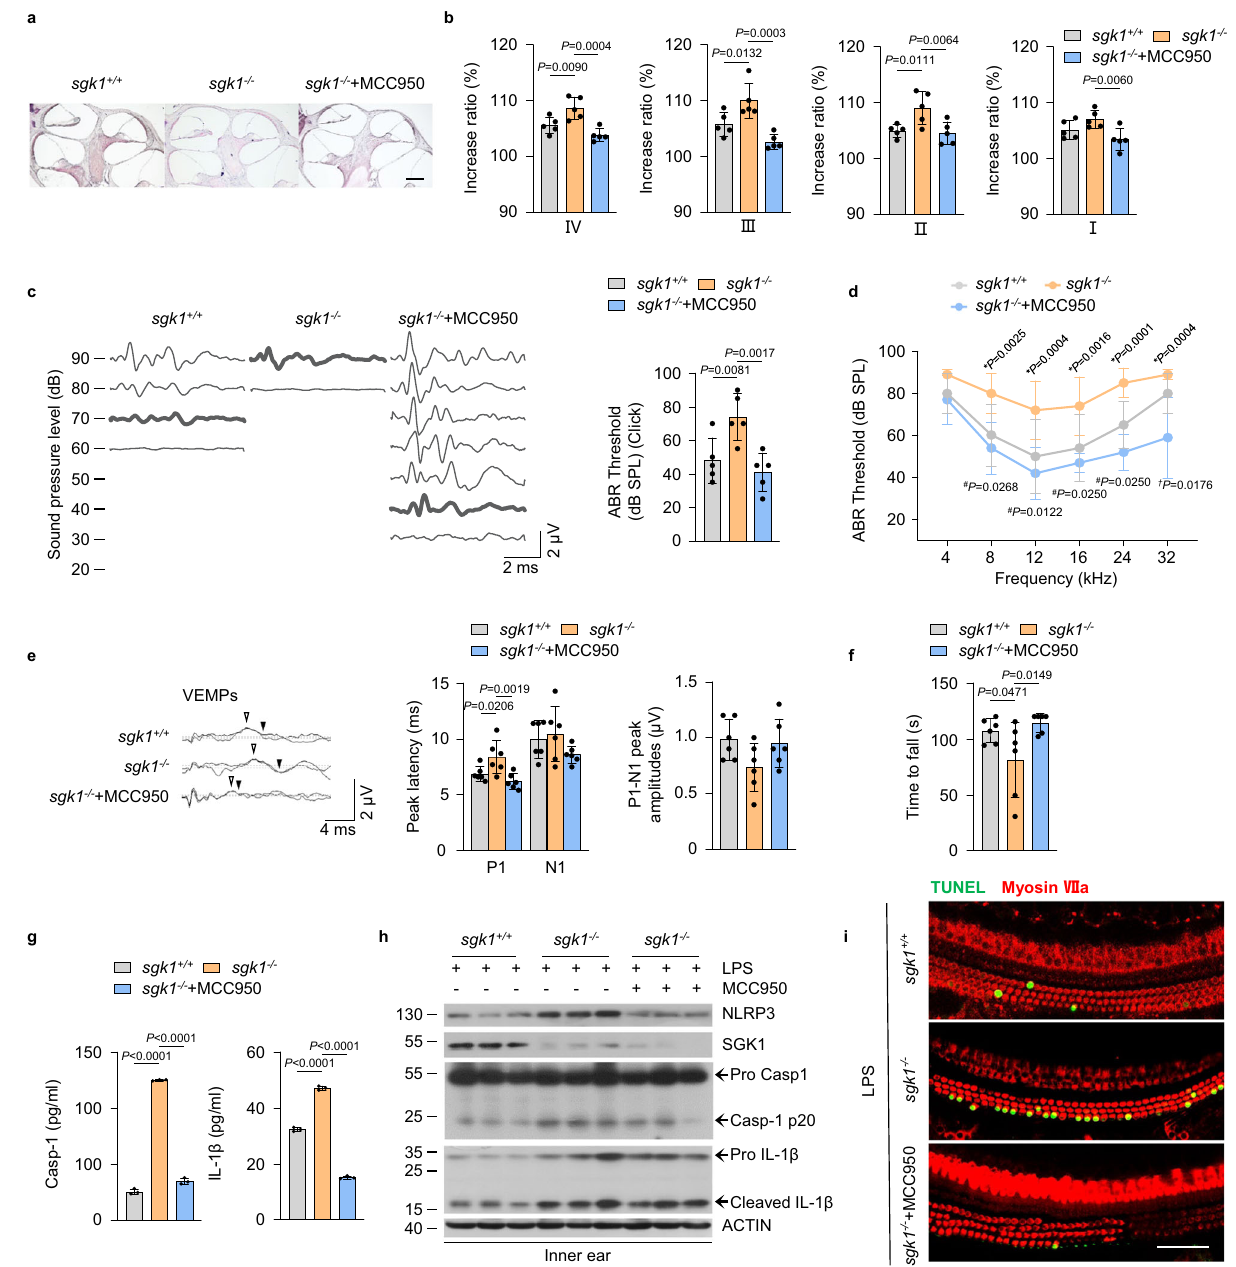
Fig. 7 | Blockade of NLRP3 signaling ameliorates EH and audiovestibular symptomsin sgk1 − / − mice. a – i The sgk1 +/+ and sgk1 − / − mice were treatedwith saline or MCC950, and followed by LPS stimulation. a Representative images of EH severityinmid-modiolarcochlearsections,scalebar=200 μ m. b Measurementsof IR-L in cochlear half-turns I – IV ( n =5 mice per group). c Representative serial ABR waverecordingsandthresholdsinresponsetoclicksounds( n =5micepergroup). d ABR thresholds in response to pure tone burst across all frequencies tested (4, 8, 12, 16, 24, and 32kHz) ( n =5 mice per group). * P indicates p -values for sgk1 − / − +LPS+MCC950 versus sgk1 − / − +LPS; # P indicates p -values for sgk1 +/+ +LPS versus sgk1 − / − +LPS; † P indicates p -values for sgk1 +/+ +LPS versus sgk1 − / − +LPS+ MCC950. e Representative click-evoked VEMP waves, P1-N1 peak amplitudes, and theP1(whitetriangle)andN1(blacktriangle)peaklatenciesofVEMPsat100dBnHL